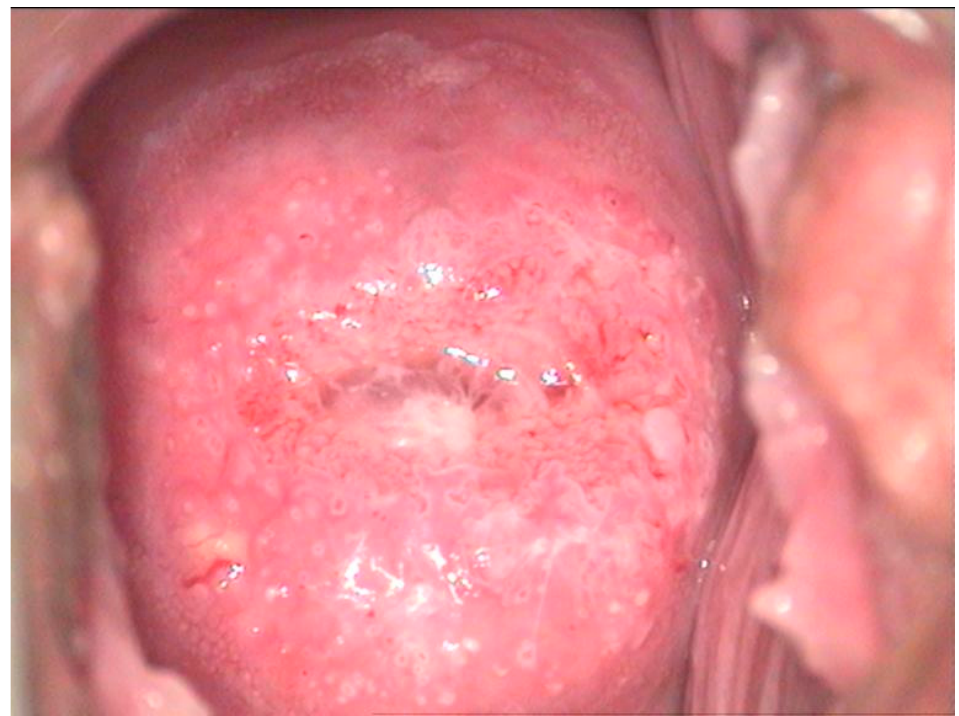
Figure 6. Polymorphic colposcopic image—circumferential aceto-white epithelium with intraglandular squamous transformation, papillary proliferation on the anterior lip, and peripheric fine mosaic; ASCUS PAP smear.